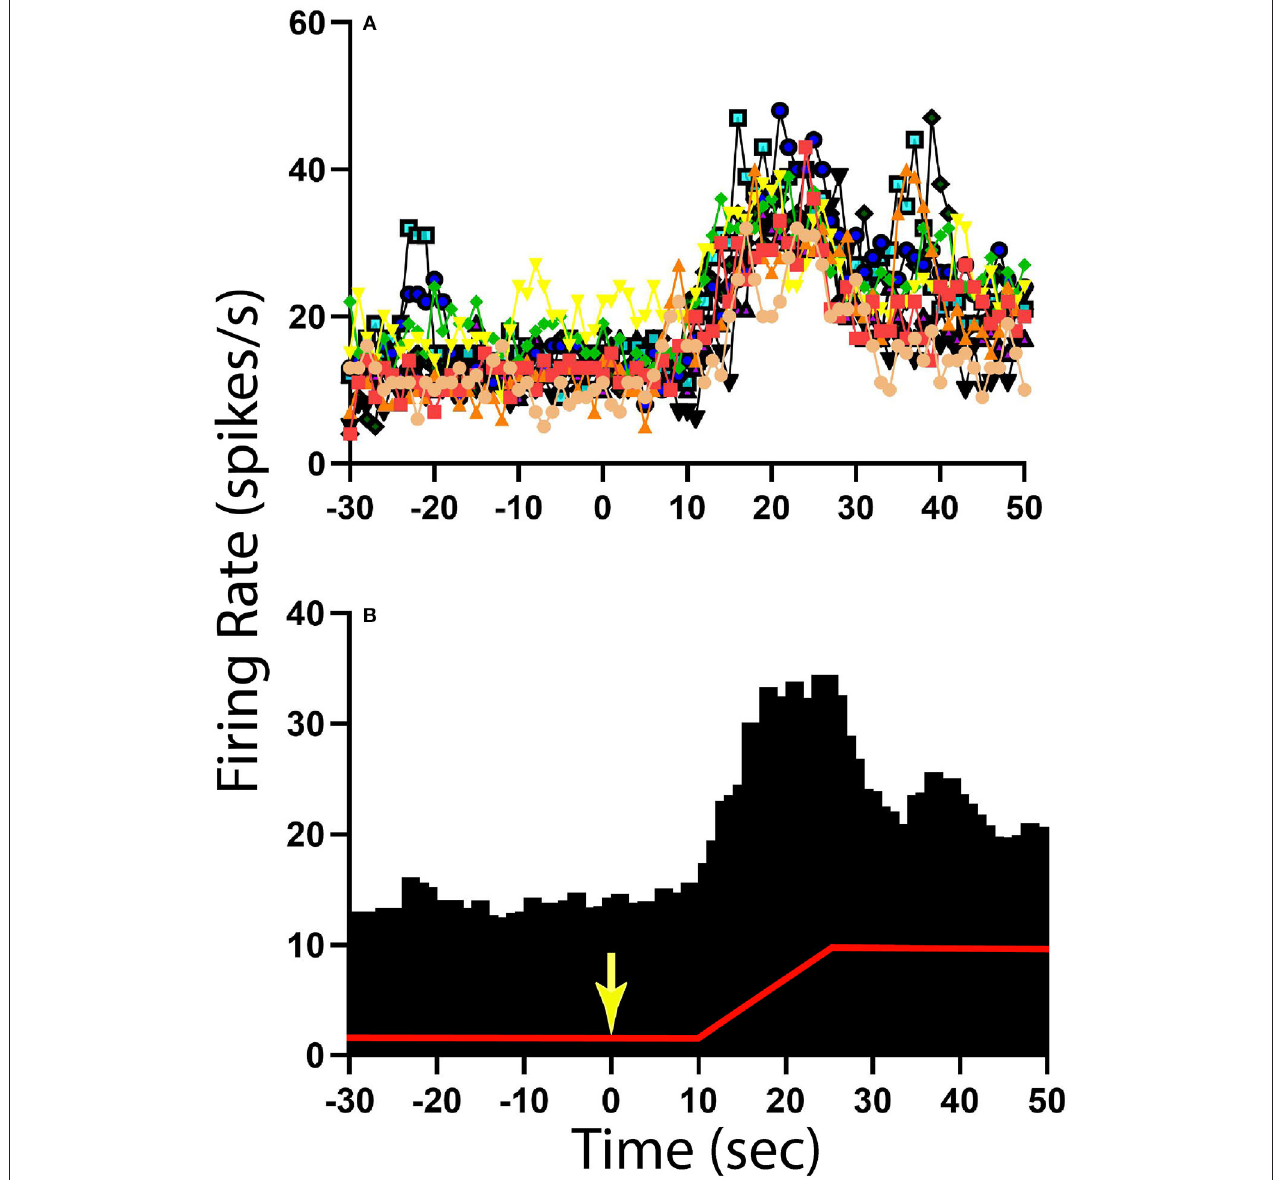
FIGURE 5 | Change in activity for one NTS unit with CRA during 40 ◦ head-up tilt. (A) Unit activity during 1s bins for 10 individual trials; each trial is demarked by lines of different colors as well as different symbols. (B) Histogram of averaged activity during 1s bins for all trials. The red line designates table position; the transition from 20 ◦ nose-down to the 20 ◦ nose-up position (40 ◦ change in animal position) occurred 10s after the light cue, which is demarked by a yellow arrow.